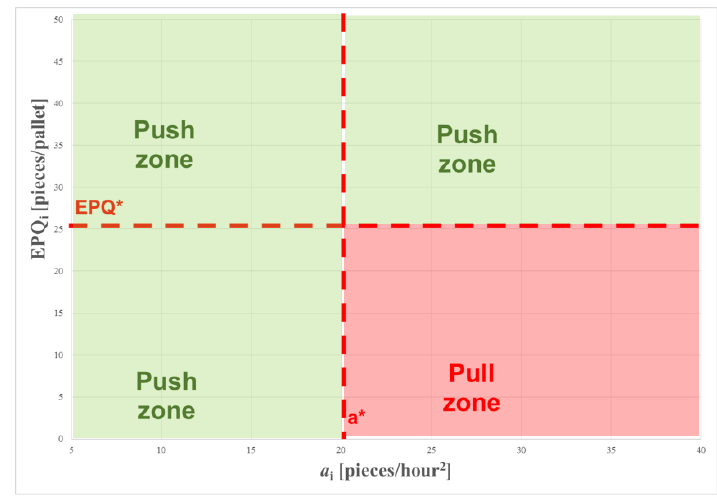
Figure 3. Potential Push-Pull zones in 𝑎 𝑖 and 𝐸𝑃𝑄 𝑖 diagram.